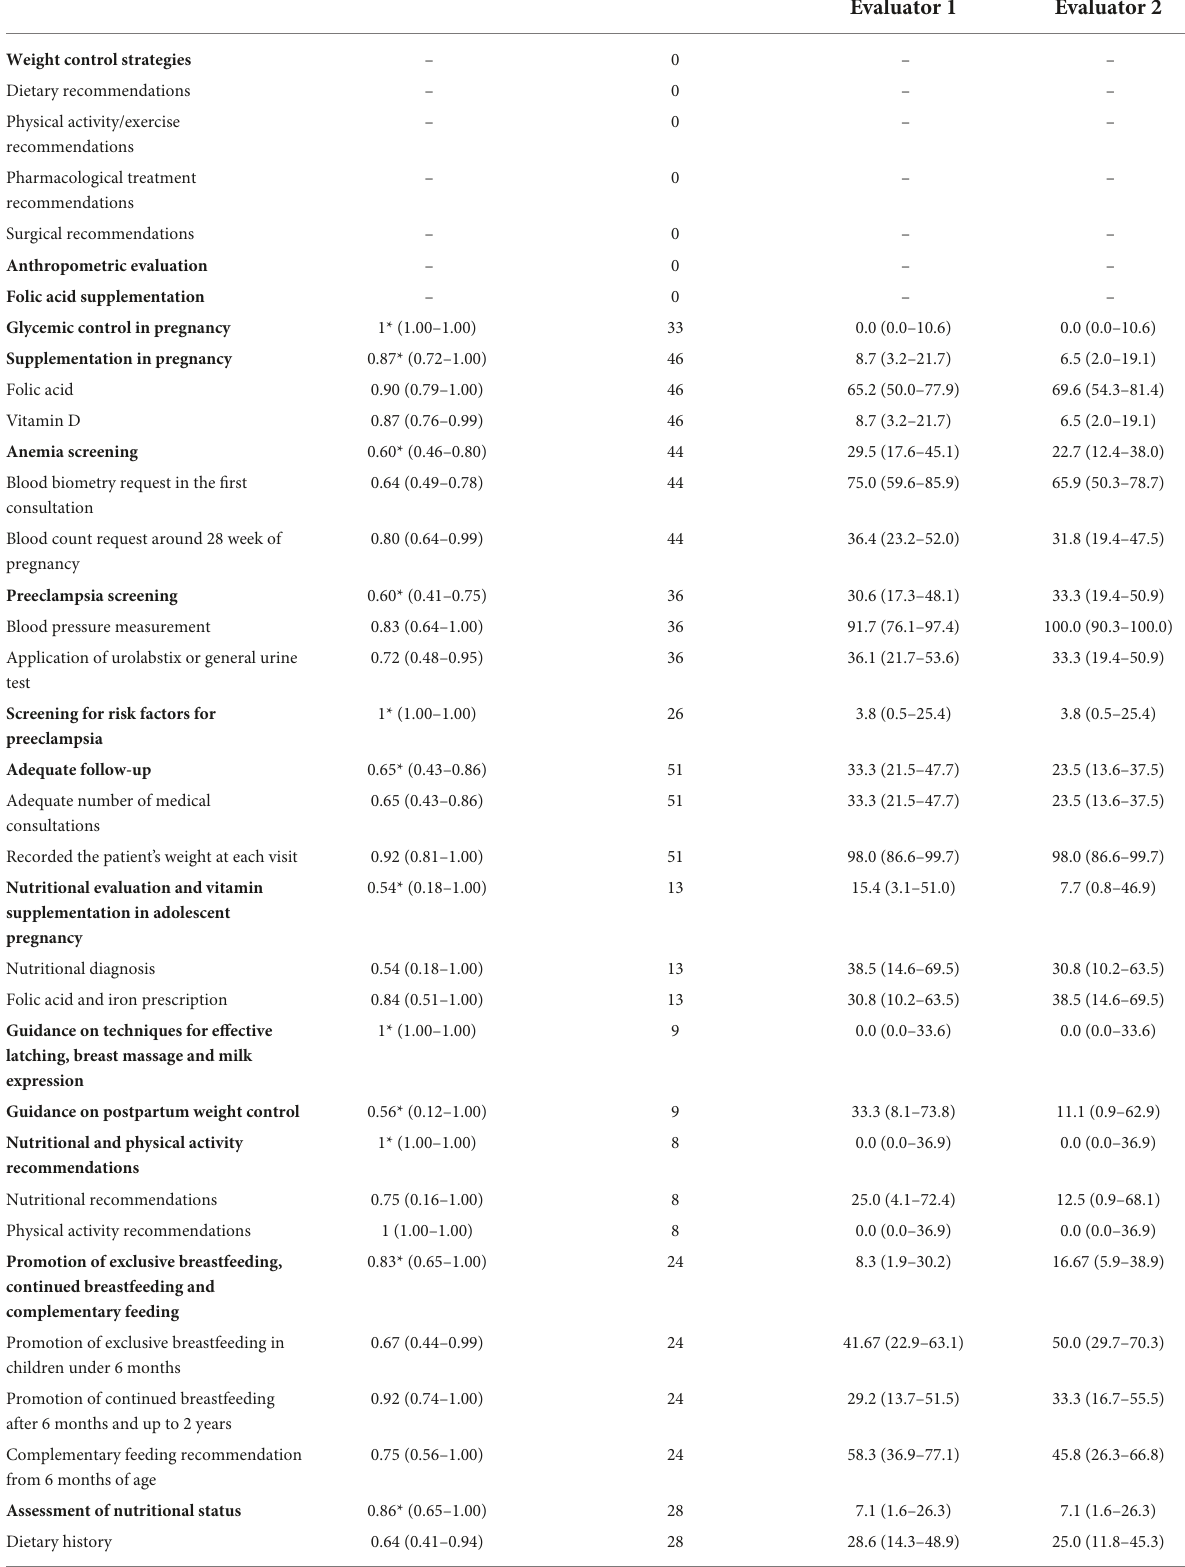
TABLE 3 Reliability of the quality indicators of maternal and child nutritional care at primary care. Name of the indicator and